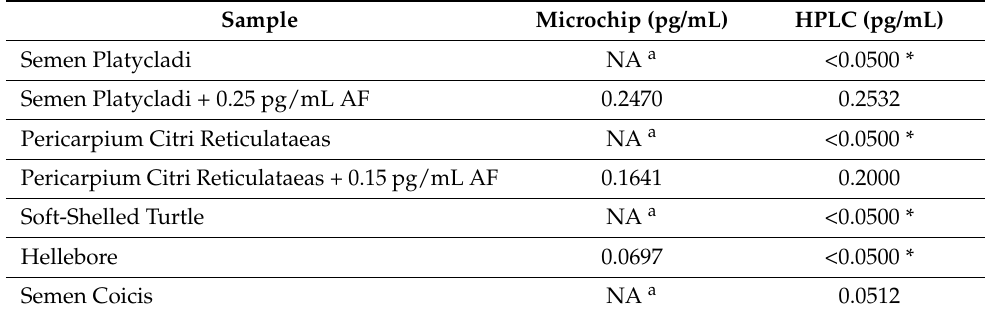
Table 1. Measurements of total aflatoxin in samples from microchip and HPLC. Sample Microchip (pg/mL) HPLC (pg/mL) Semen Platycladi NA a <0.0500 * Semen Platycladi + 0.25 pg/mL AF 0.2470 0.2532 Pericarpium Citri Reticulataeas NA a <0.0500 * Pericarpium Citri Reticulataeas + 0.15 pg/mL AF 0.1641 0.2000 Soft-Shelled Turtle NA a <0.0500 * Hellebore 0.0697 Semen